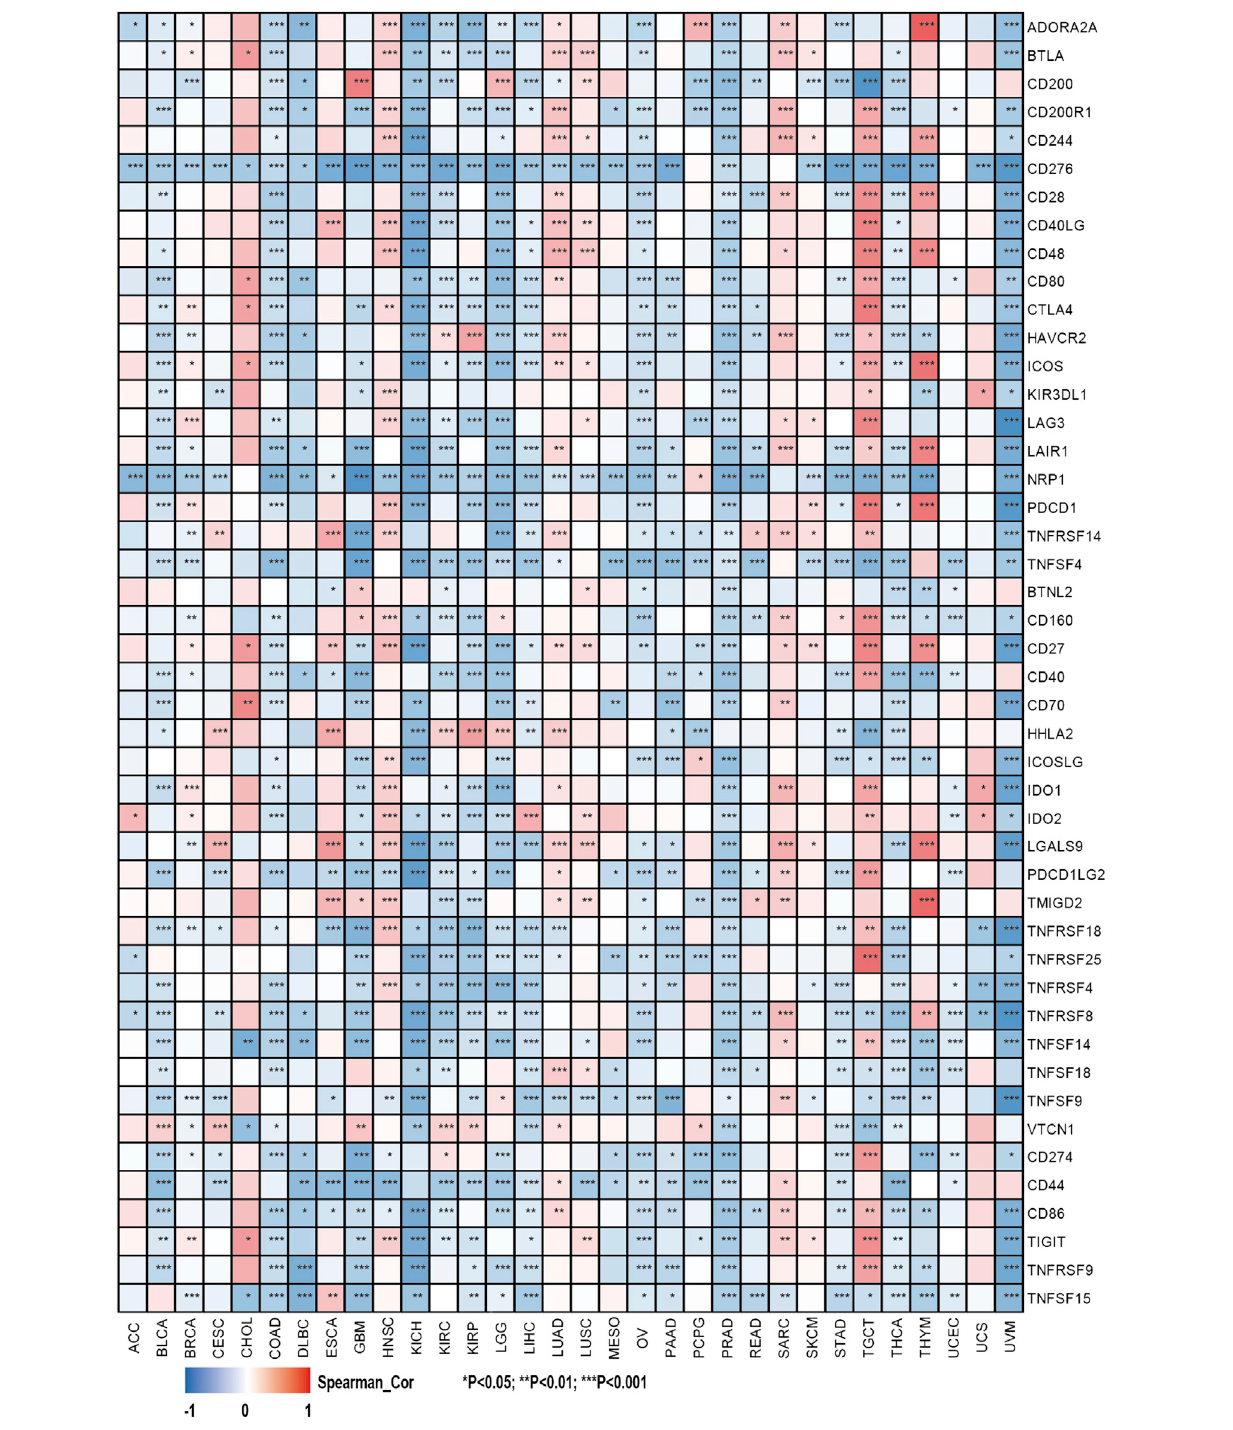
Frontiers in Genetics |